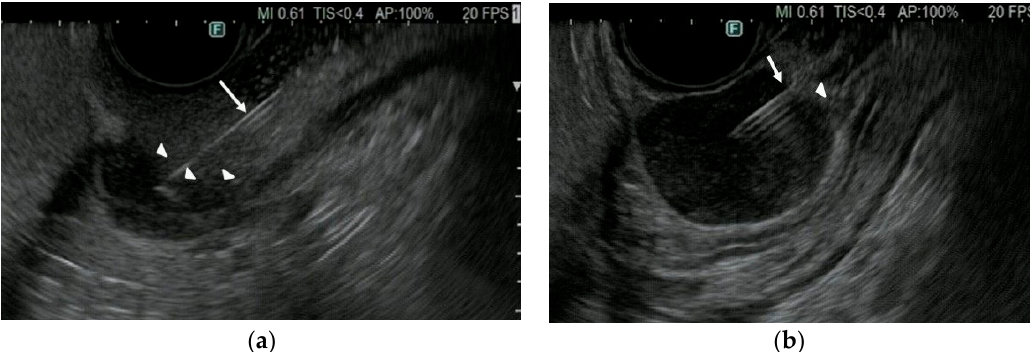
Figure 3. EUS imaging between Franseen (Acquire TM ) and Fork-tip (Shark Core TM ) needle in puncturing SEL. ( a ) Franseen needle (arrow) did not puncture SEL but pushed the surface of SEL (arrowhead). ( b ) Fork-tip needle (arrow) sharply punctured SEL (arrowhead). EUS, endoscopic ultrasound; SEL, subepithelial lesions.